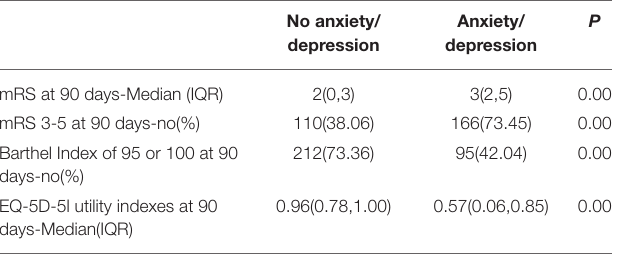
TABLE 4 | Clinical outcomes in patients of anxiety/depression group and no anxiety/depression group.